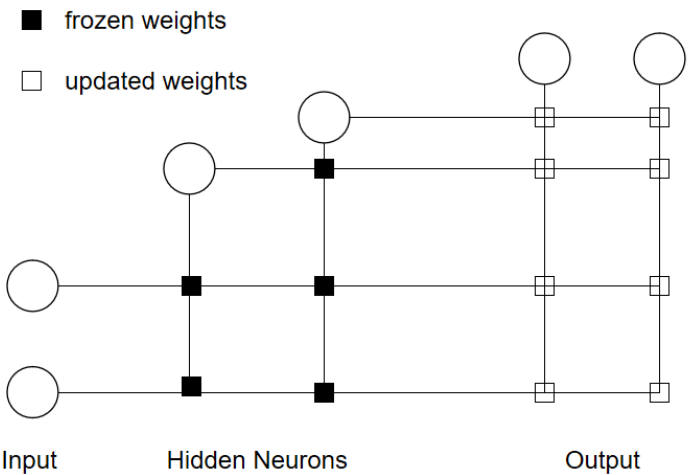
Figure 1. Training process of the Cascade Correlation Neural network.